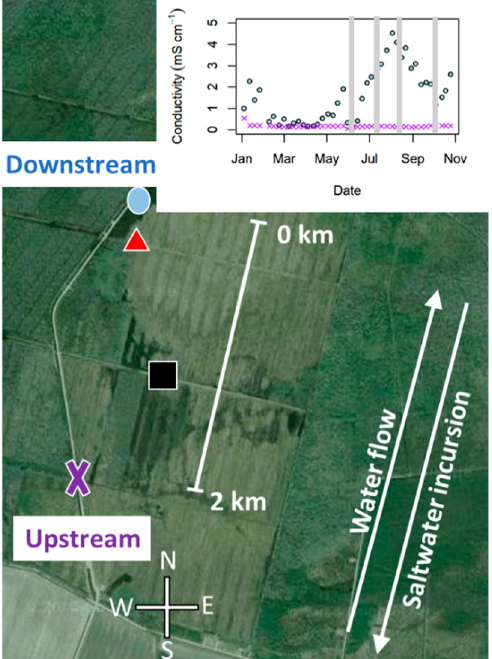
Figure 1. Map of sampling locations (colored shapes) along the salt-influenced downstream (northern end) to largely freshwater upstream (southern end) two kilometer transect. Freshwater flows south to north, while saltwater incursion pushes inland north to south. Insert depicts the specific conductivity of surface water (light blue circles = downstream site, purple crosses = upstream site) over the year [3]. The sampling dates are indicated by grey vertical lines.